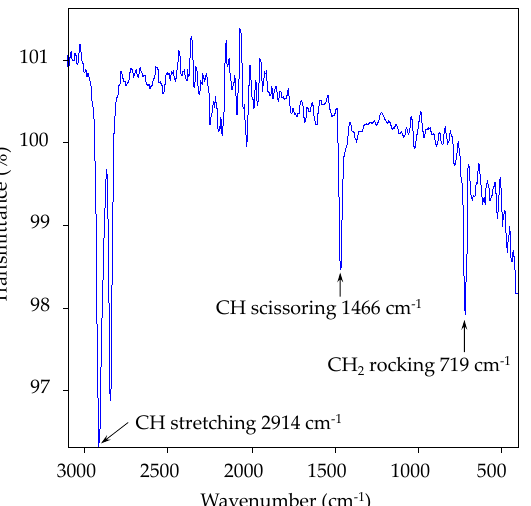
Figure 10. FTIR spectrum of a particle collected from tap water identified as polyester.